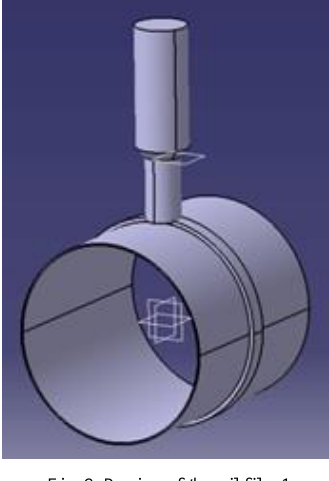
Fig. 2. Design of the oil film